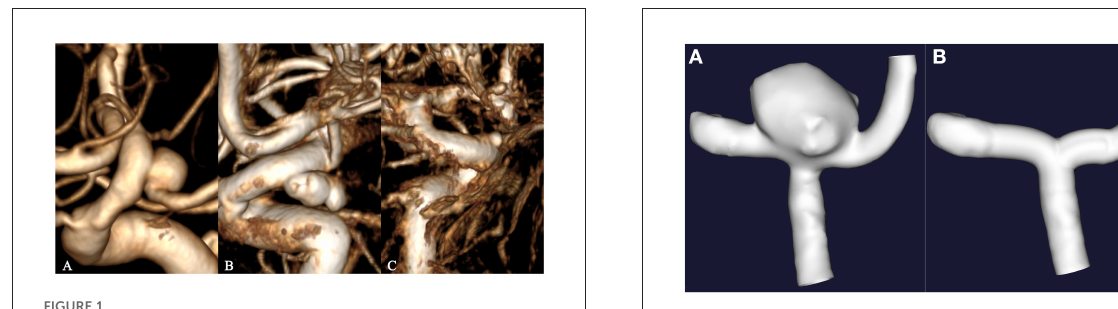
FIGURE2 The interpolation method was implemented to remove the sacral cerebral aneurysm from its parent artery. (A) Original 3D images. (B) Only with retention of the 3D images of the parent